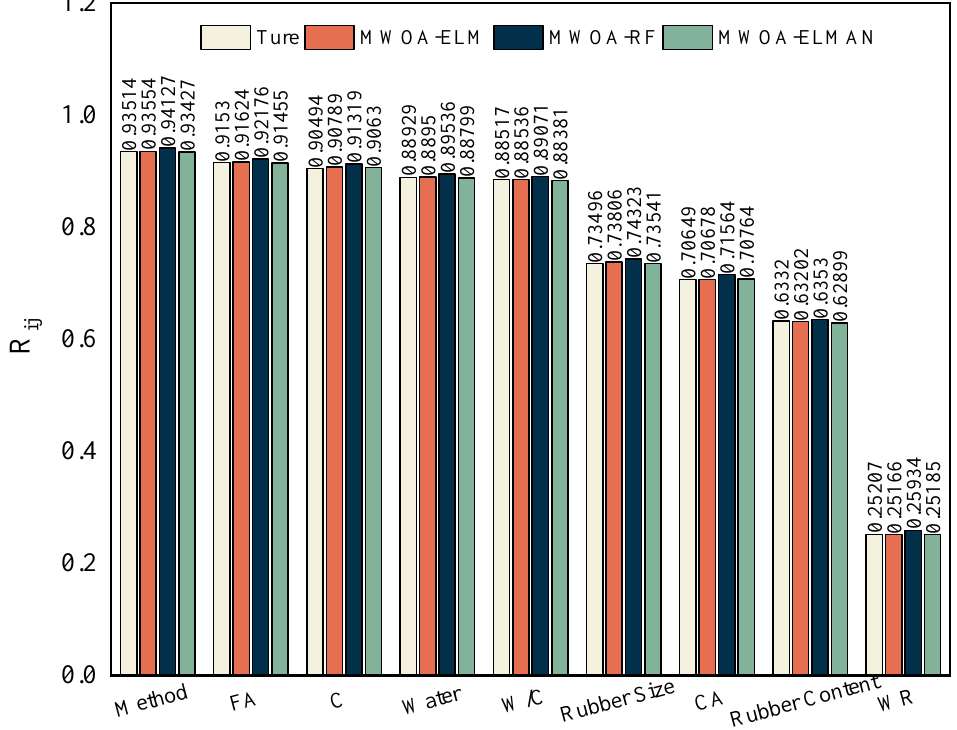
Figure 14 represents the strength factor of the relationship between each variable and D CI . It can be seen that the three models show similar sensitivity to the experimental model, justifying the developed model. As seen from the graph, the measurement method has the most significant effect on the D CI of RC, followed by FA, while the impact of WR is the least.